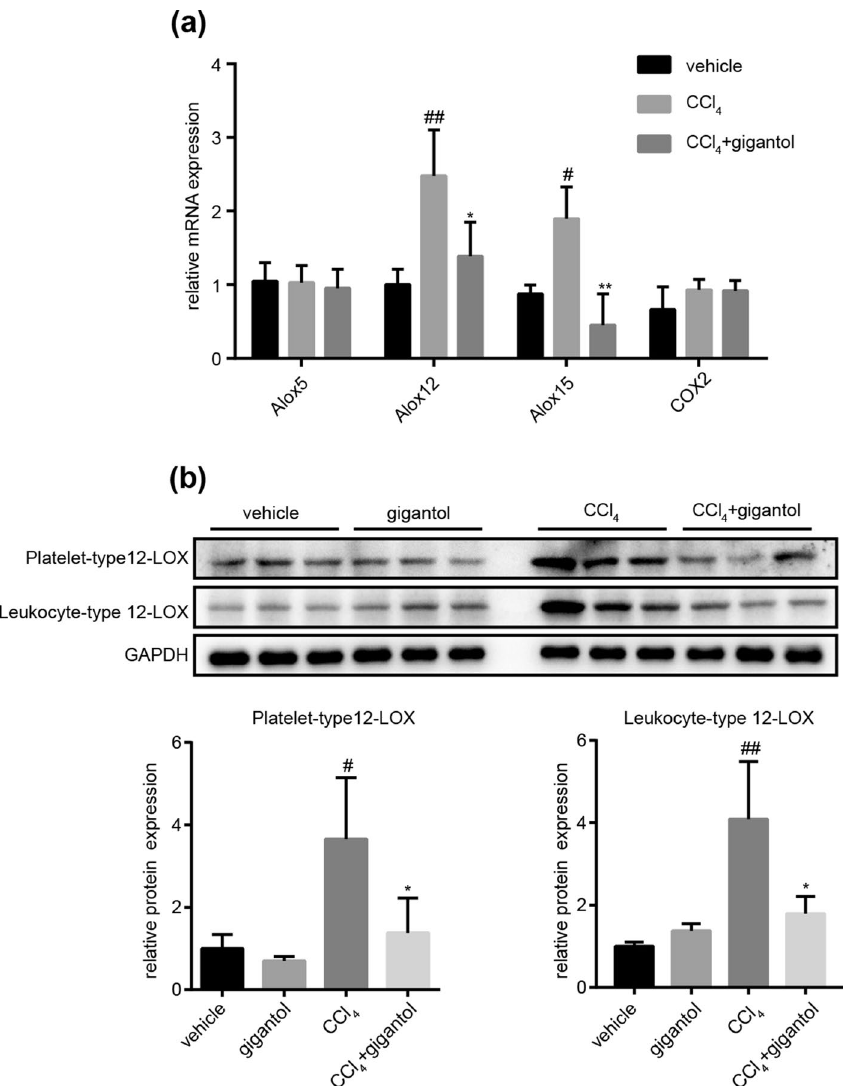
Figure 5. Gigantol significantly inhibited the 12-LOX pathway. ( a ) The relative mRNA expression of Alox5, Alox12, Alox15 and COX2 in the mouse livers from the vehicle, CCl 4 and (CCl 4 + gigantol) groups. ( b ) The protein expression of platelet-, and leukocyte-type 12-LOX in the mouse livers at 16 h post CCl 4 injection. The representative western blot bands are shown, n = 3 western blot experiments. The quantitative results are represented as the mean ± SD, n = 6 mice in each group. ## P < 0.01, # P < 0.05 versus the vehicle group; **P < 0.01, *P < 0.05 versus the CCl 4 group. Full-length blots are presented in Supplementary Figure